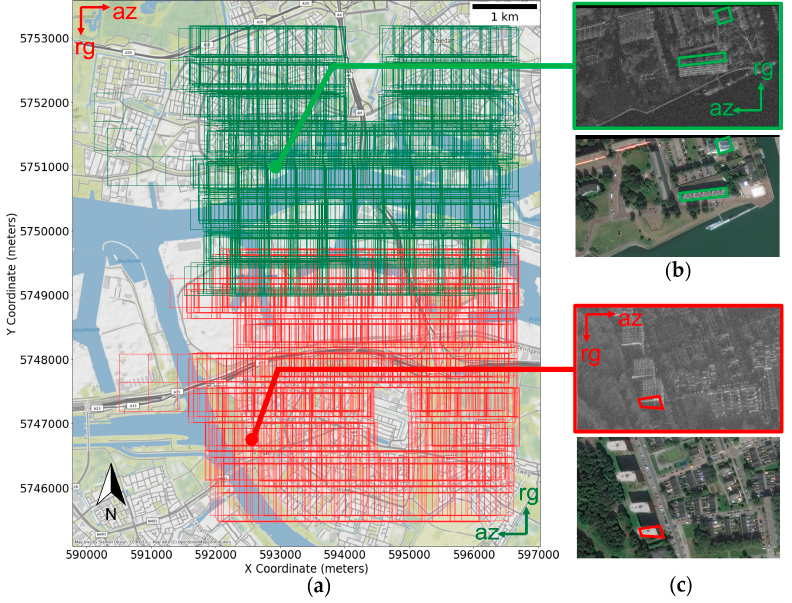
Figure 2. ( a ) The map of Rotterdam Port area (UTM Zone 31N) overlayed with tile boundaries for all 3401 tiles in the SpaceNet6 training set. Green tiles are orient1 while red tiles are orient0. To showcase the data augmentation methods in this study, we only use the green tiles (orient1) for training. Some building footprints are highlighted as an example of layover effects in ( b ) orient1 and ( c ) orient0 tiles. Notice the direction of a layover is always projected towards the sensor’s position (near range) while the shadow is cast away from the sensor. The optical RGB image is provided for comparison.